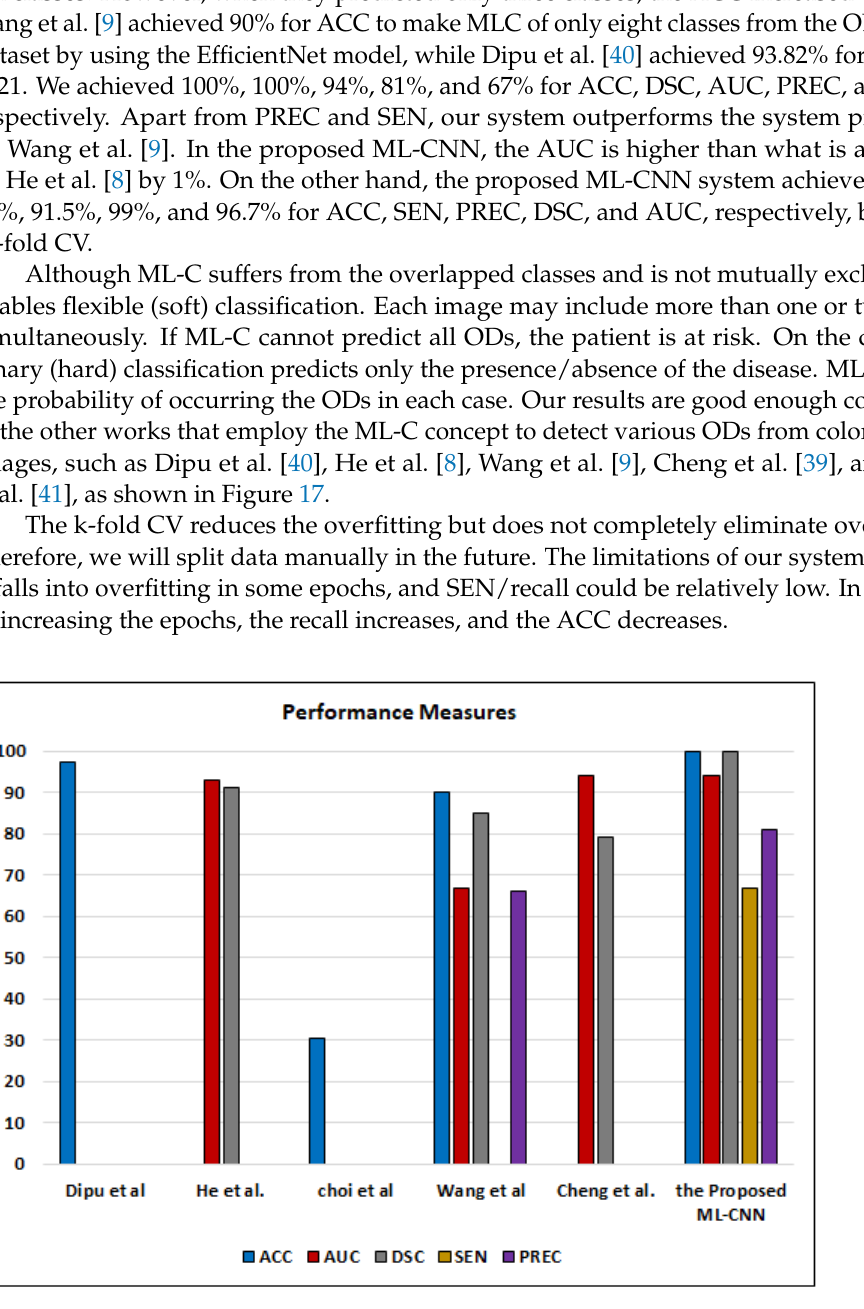
Figure 17. The comparison between some current ML-C studies and the proposed